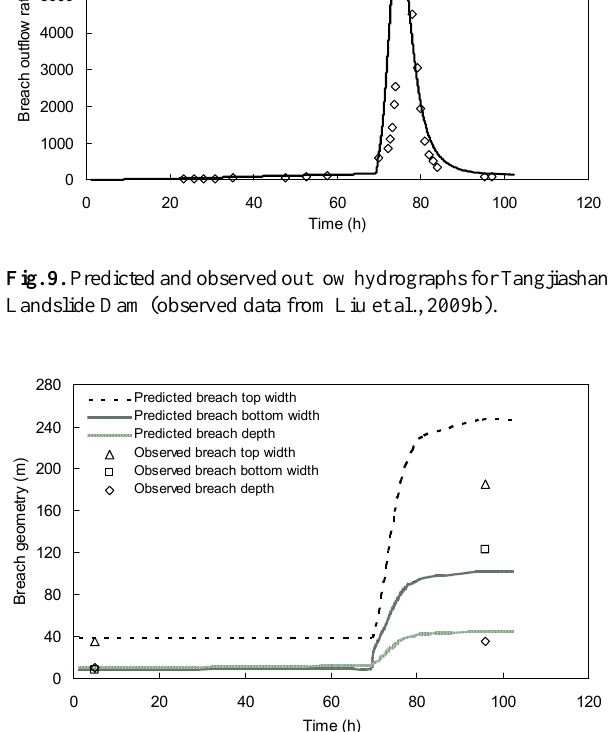
Fig. 10. Predicted and observed evolution of breach size for the Tangjiashan landslide dam.